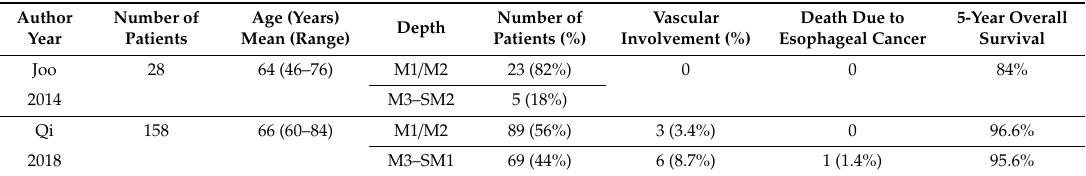
Table 2. Long-term outcomes of endoscopic submucosal dissection for superficial esophageal squamous cell carcinoma without additional